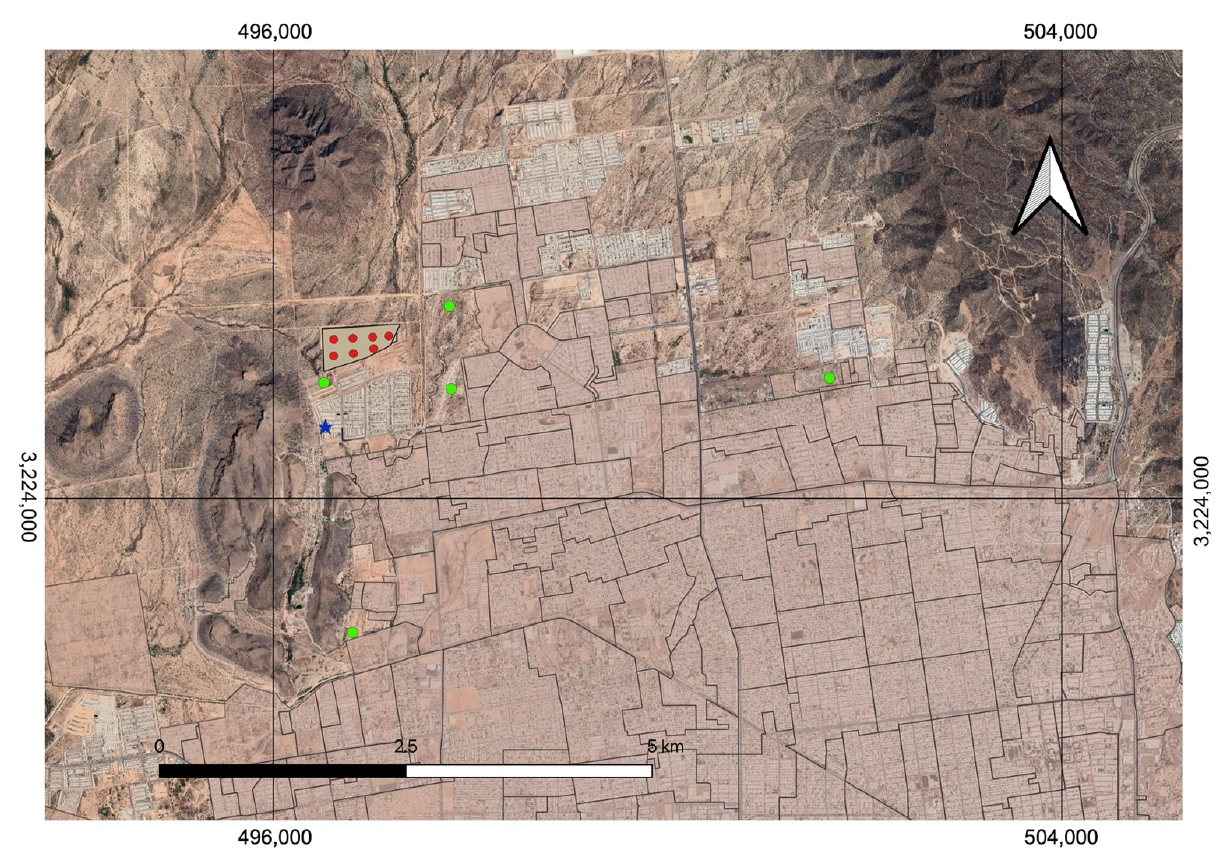
Figure 3. Location of suitable soils for infiltration in the northwest of Hermosillo (green dots). Blue star indicates the ideal site identified in previous studies, where the 2D tomography was conducted (Figure 4) but had to be excluded for the park because it experienced rapid development, and the red dots indicate the monitoring sites within the selected site for this study (credit: B. González-Méndez and J. Valencia-Sauceda).